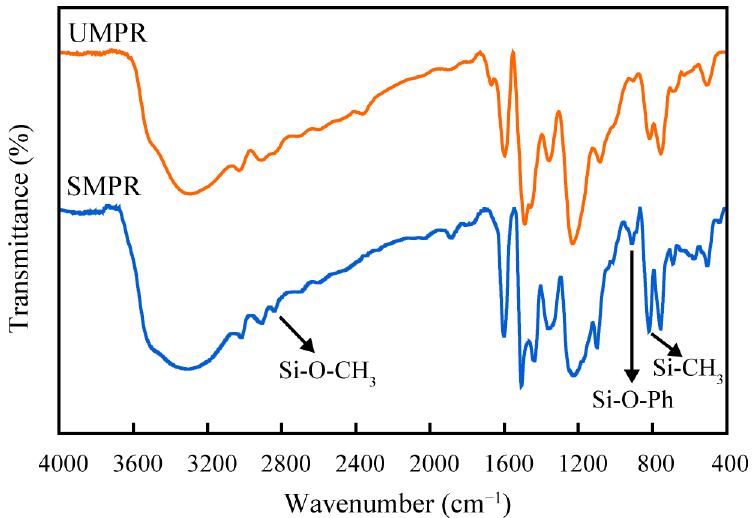
Figure 5. Infrared spectra of unmodified phenolic resin and silicone-modified phenolic